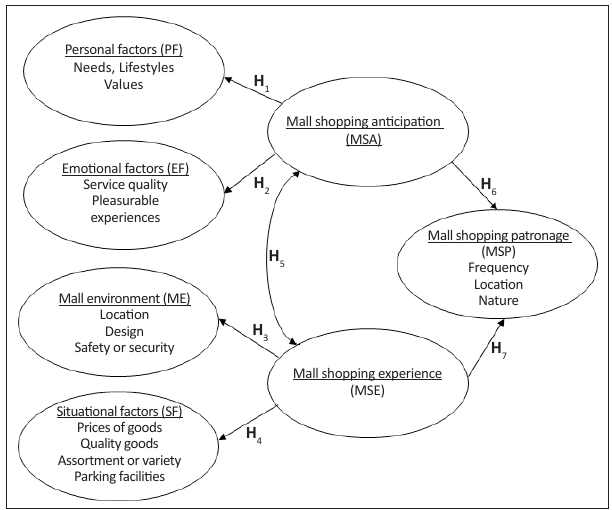
FIGURE 1: Theoretical model – Factors that influence mall shopping